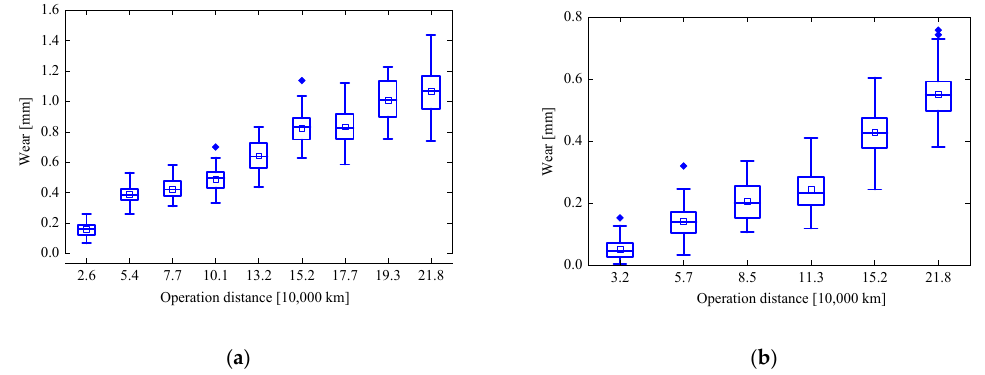
Figure 1. Wheel wear in one re-profiling interval: ( a ) Line A; ( b ) Line B.